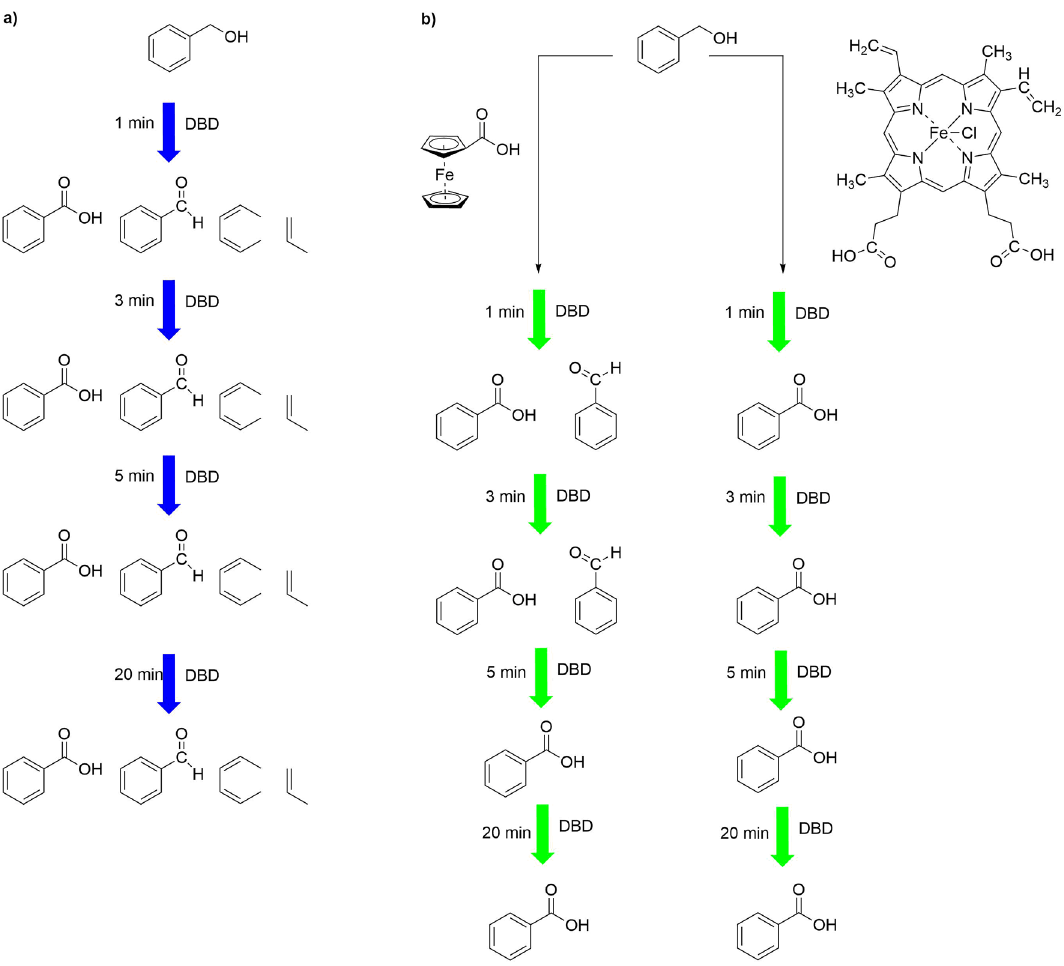
Figure 5. Chemical modifications of benzyl alcohol after different times of plasma treatment ( a ) without iron complexes, ( b ) in the presence of iron